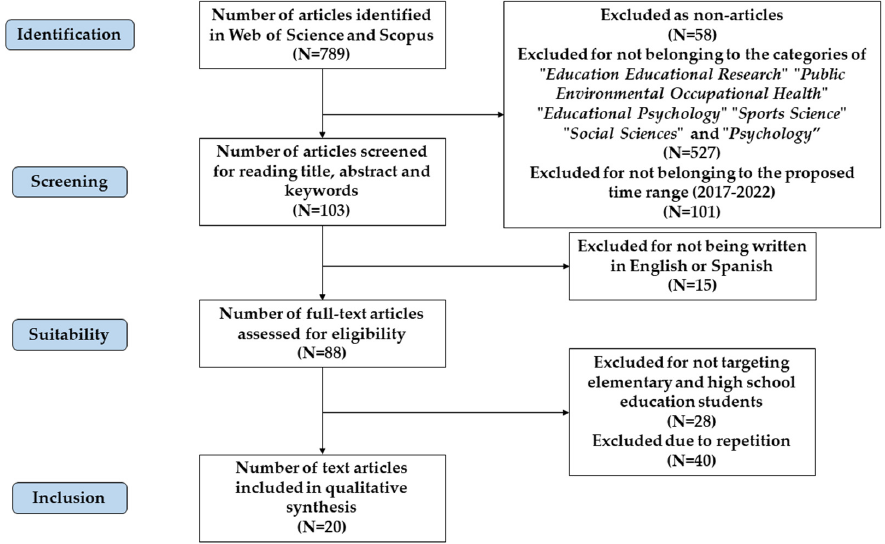
Figure 1. Flow chart of the base body of valid studies for qualitative synthesis.